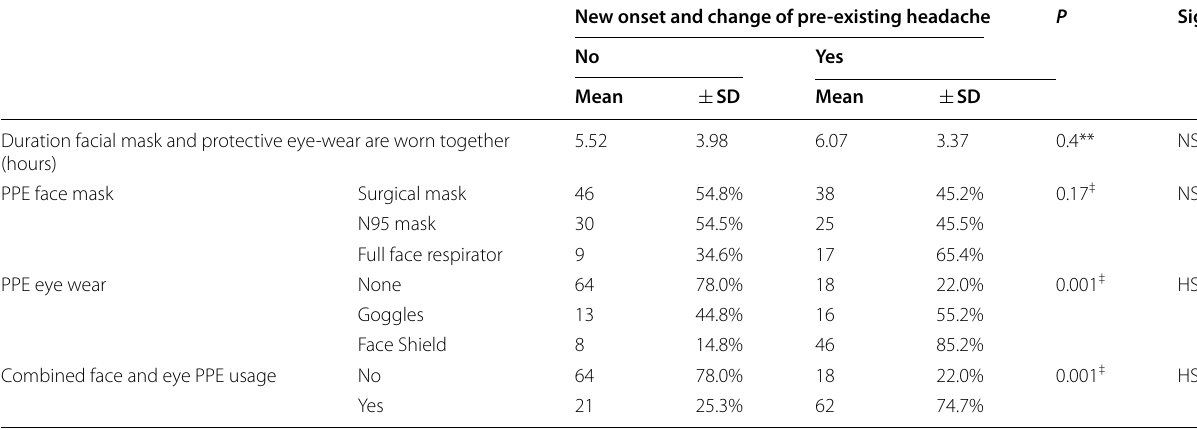
Table 5 Comparison between physicians with and without out new onset headache (including those with newly altered headache) as regard working hours and PPE usage